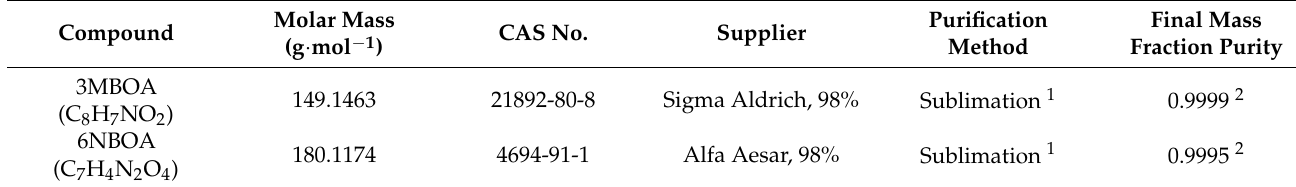
Table 6. Provenance and mass fraction purity of the compounds